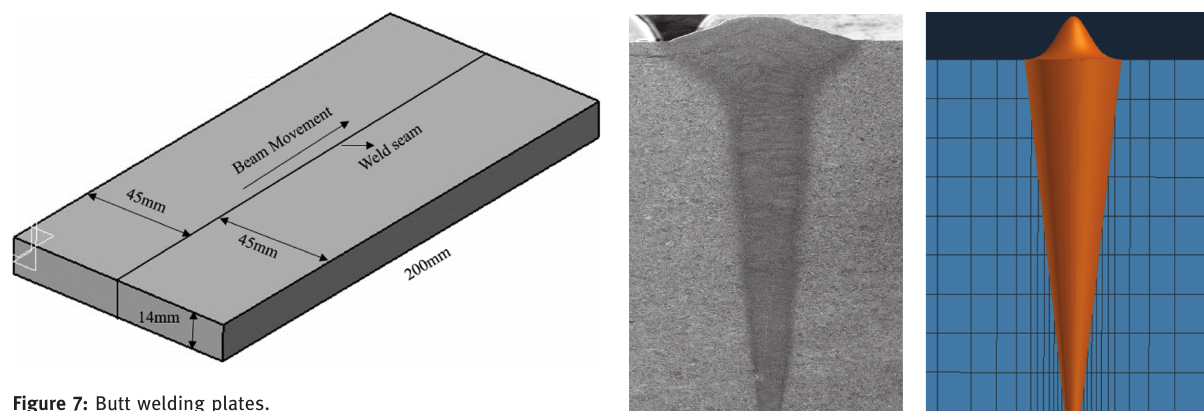
(a) Experiment joint shape (b) Predicted joint